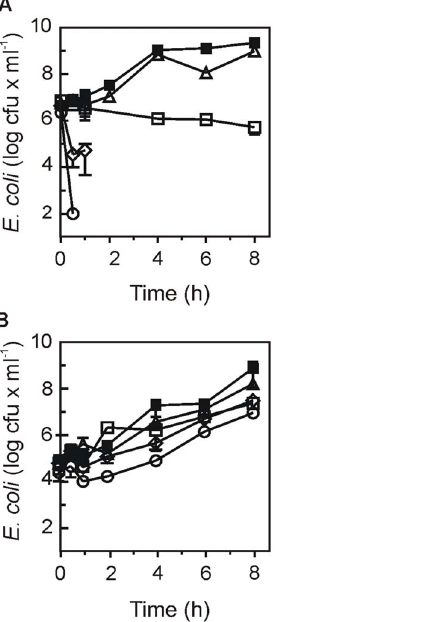
Figure 5. Effect of adaptation to lettuce leaves on Escherichia coli K12 tolerance to oxidative stress. Survival of (A) non-adapted bacteria (cultivated in LB medium) or (B) plant-adapted bacteria (isolated from leaves) after incubation for 0 to 8 h in the presence of ( & ) 0; ( D ) 0.5; ( % ) 2; ( e ) 8; or ( # ) 32 mM H 2 O 2 . Data represent the mean and SD of 2 independent assays.